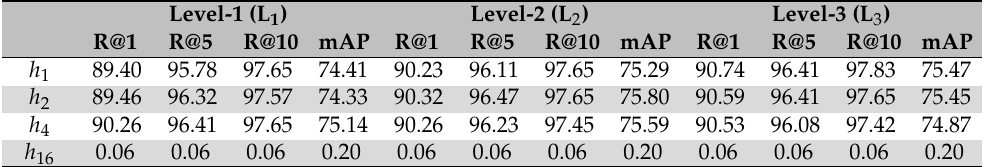
Figure 7. Sample images from the Market-1501 dataset to show the visual explanations of Residual-Transformers against the baseline method. Our proposed architecture focused on the fine-grained details to re-identify. The visual attention maps are generated by baseline and transformer-based architectures using Grad-CAM++ [44] (1st row), Score-CAM [45] (2nd row), and Eigen-CAM [46] (3rd row). Table 5. The effect of the number of heads on various Residual transformers trained and evaluated on Market-1501 dataset. The worst performance is given when the number of heads is